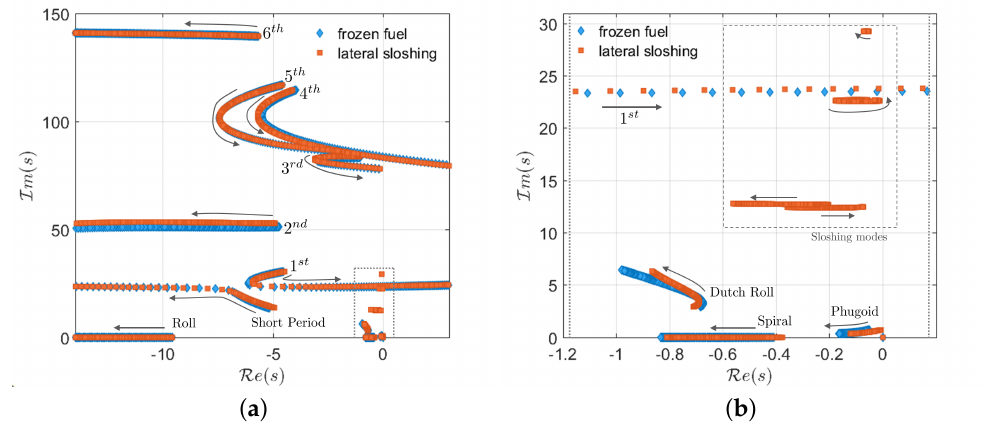
Figure 6. Root locus with linear sloshing—Test Case 1. ( a ) Root locus of the integrated system. ( b ) Focus on the rigid body and sloshing